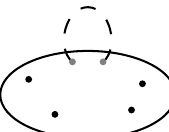
Figure 4 . Sphere with a single